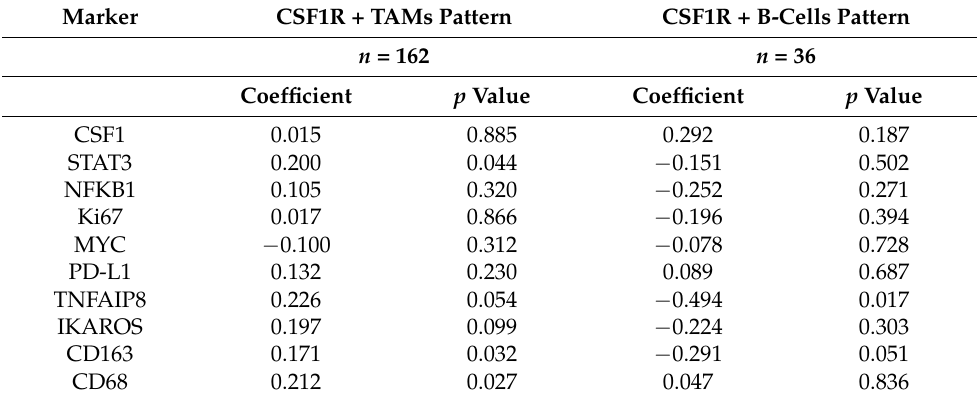
Table 6. Correlation between CSF1R and the markers of the CSF1R-pathway for each of the histologi- cal pattern (Tokai series).